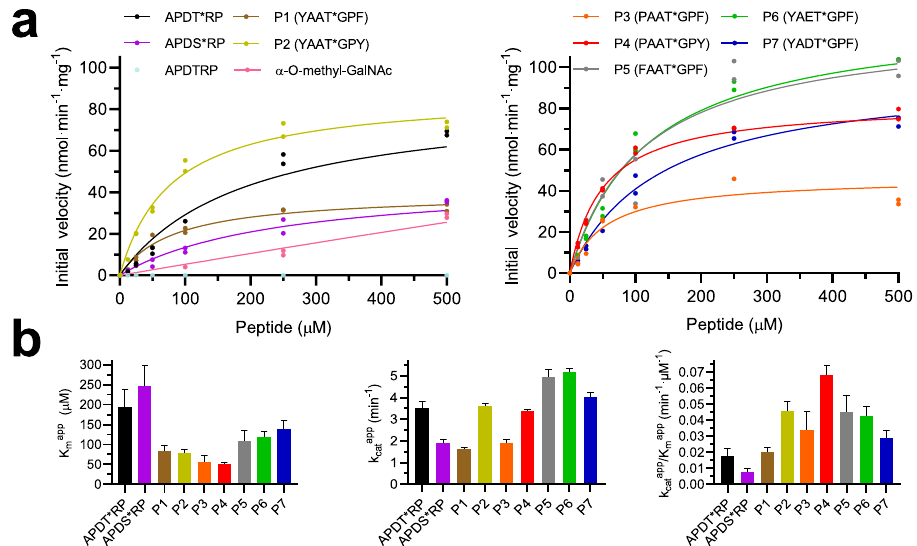
Fig. 1 Enzyme kinetics experiments of Dm C1GalT1 T43-Q388 on (glyco)peptides and α - O -methyl-GalNAc. a Glycosylation kinetics of Dm C1GalT1 T43-Q388 against (glyco)peptides and α - O -methyl-GalNAc. b Plots comparing the K m app , k cat app and the catalytic ef fi ciency ( k cat app / K m app ) between the different substrates. Additional kinetic data are given in Supplementary Table 1. Initial velocities were obtained in duplicate ( n = 2 independent experiments) for each peptide concentration. Error bars represent the standard error calculated by the GraphPad Prism fi t of the data sets. Source data are provided as a Source Data fi